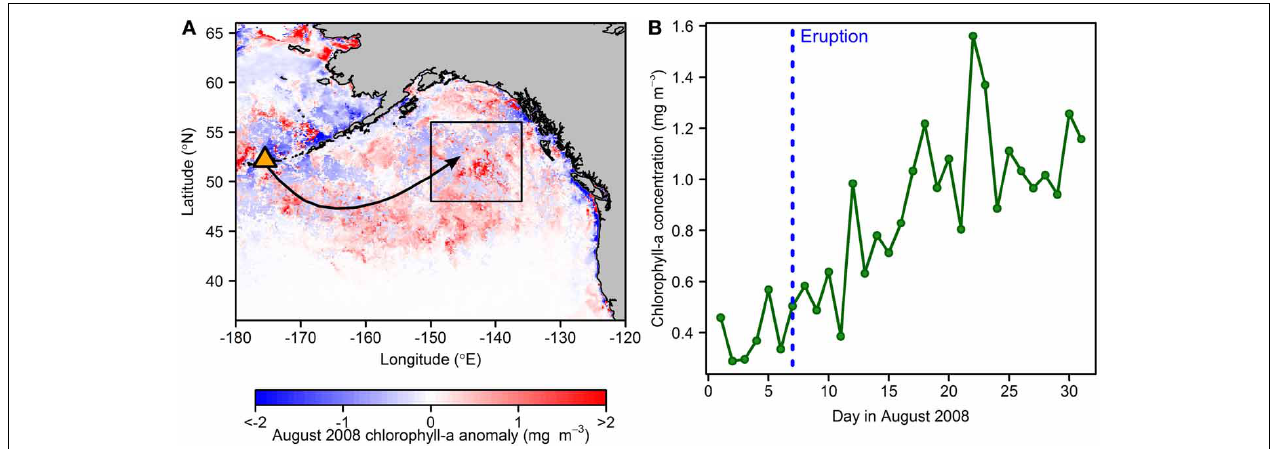
FIGURE 3 | Enhanced chlorophyll-a concentrations subsequent to the Kasatochi 2008 eruption (after Hamme et al., 2010; Langmann et al., 2010a,b). (A) August 2008 chlorophyll-a anomaly relative to the 2002–2013 August average. The Kasatochi volcano has been identified with an orange triangle; the general trajectory of the